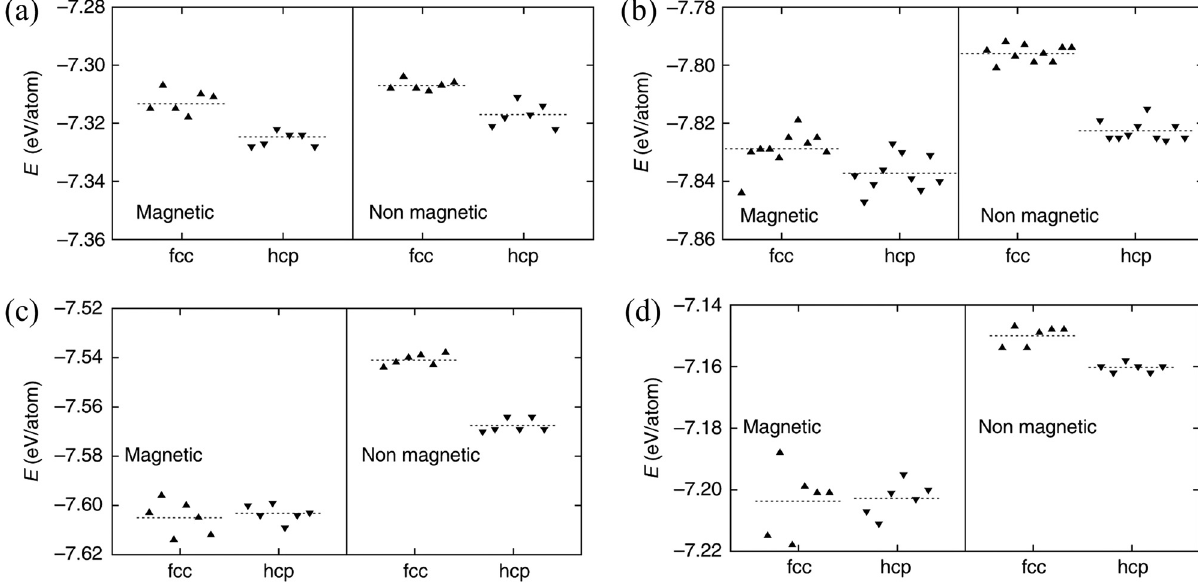
Figure 5: E ff ect of magnetic properties on the free energy of HCP and FCC phases in alloys: ( a ) CrCoNi, ( b ) CrMnFeCoNi, ( c ) NiFeMn, and ( d ) NiCoMn [ 25 ]